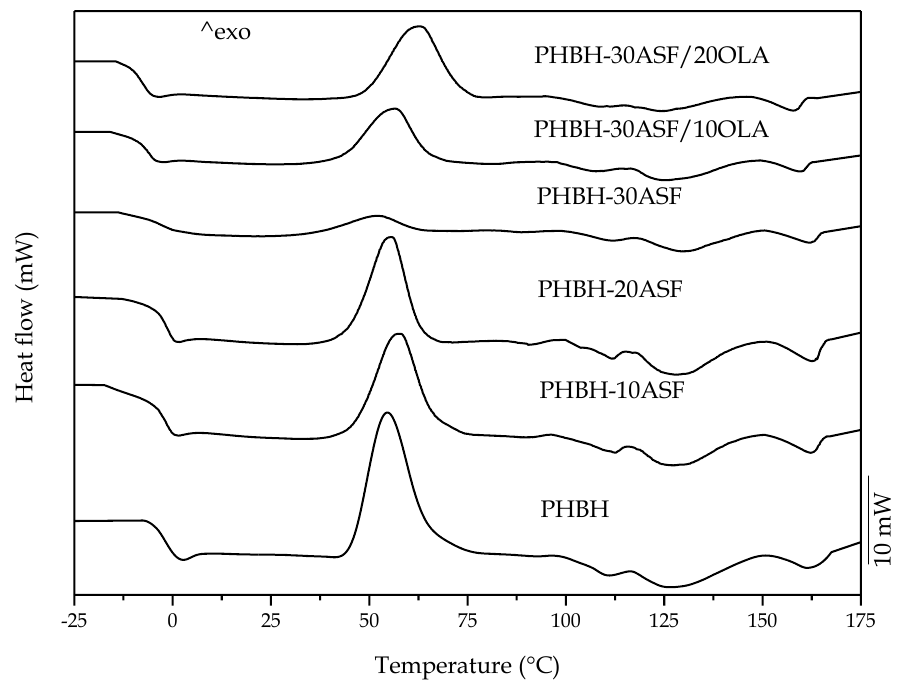
Figure 3. Comparative plot of the second heating curves obtained by dynamic differential scanning calorimetry (DSC) of the different PHBH-ASF/OLA composites with different compositions. Table 3. Main thermal parameters of the PHBH-ASF/OLA composites with different compositions, obtained by differential scanning calorimetry (DSC).